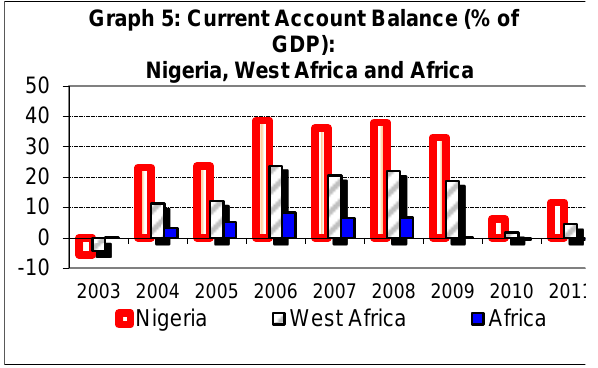
Nigeria West Africa